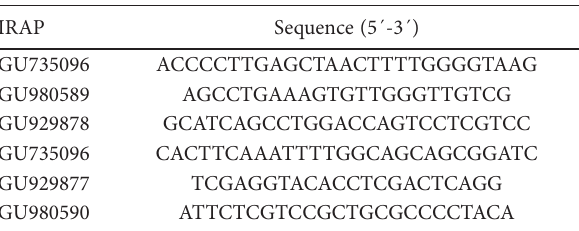
Table 2. IRAP primers based on SMYKAL et al. (2011) study.